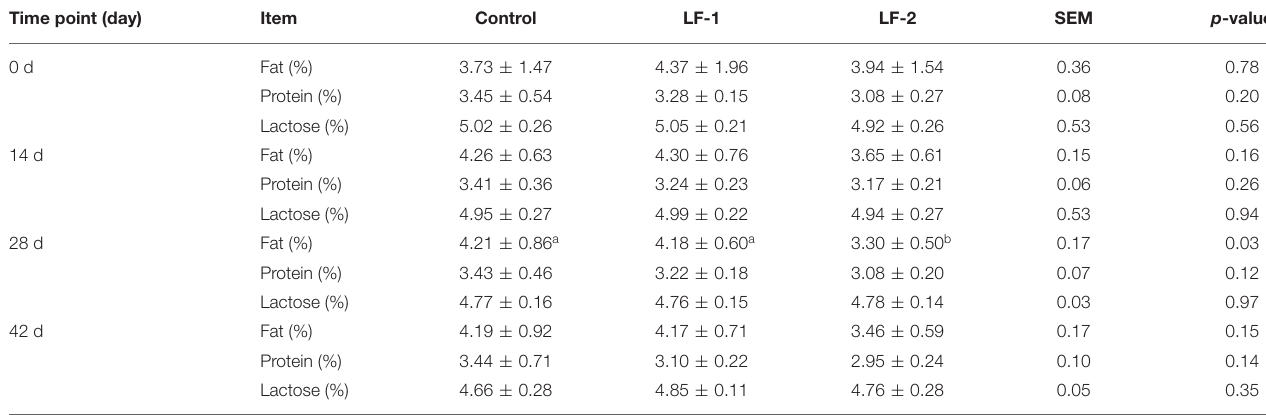
TABLE 4 | The effects of supplementation of BLFc at the rate of 100 mg/kg/day (LF-1) or 200 mg/kg/day (LF-2) on the milk composition in dairy goats. Time point (day) Item